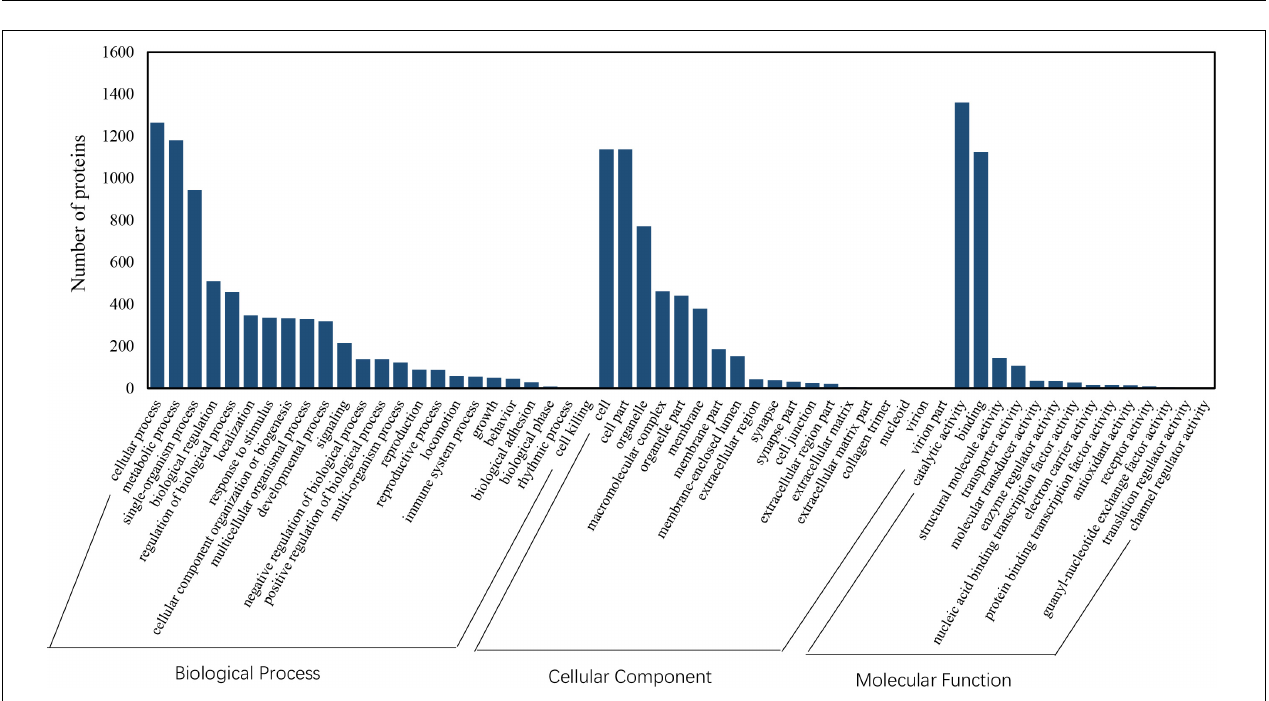
FIGURE 6 | Variation in trends between DEGs and DEPs from the same locus. (A) represents DEGs and DEPs with the same trend, while (B) represents DEGs and DEPs with opposite trends. Scatter plots illustrate the distribution of differentially expressed proteins and related genes. The Pearson correlation coefficient between protein and mRNA expression profiles is shown in the upper left corner of the plot.